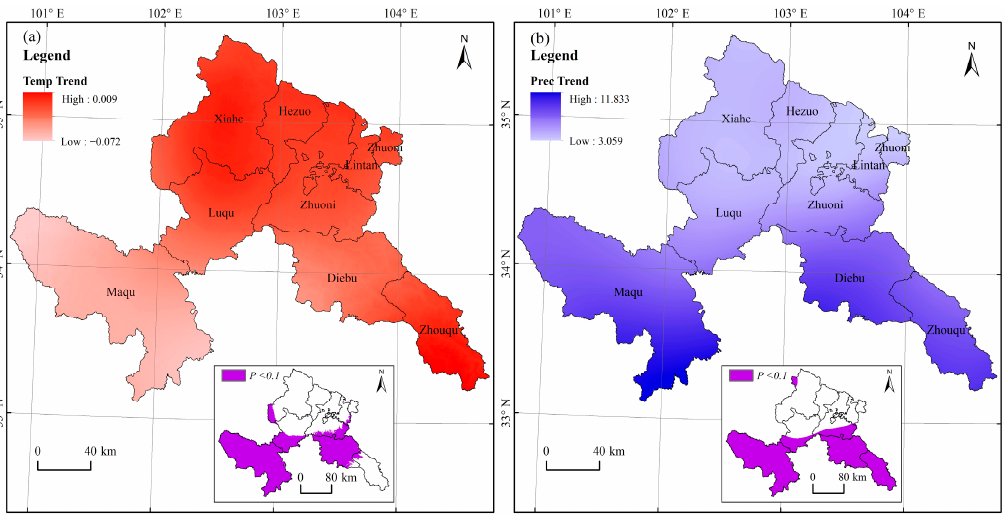
Figure 7. Change trend of air temperature ( a ) and precipitation ( b ) in Gannan Prefecture during 2000–2020.